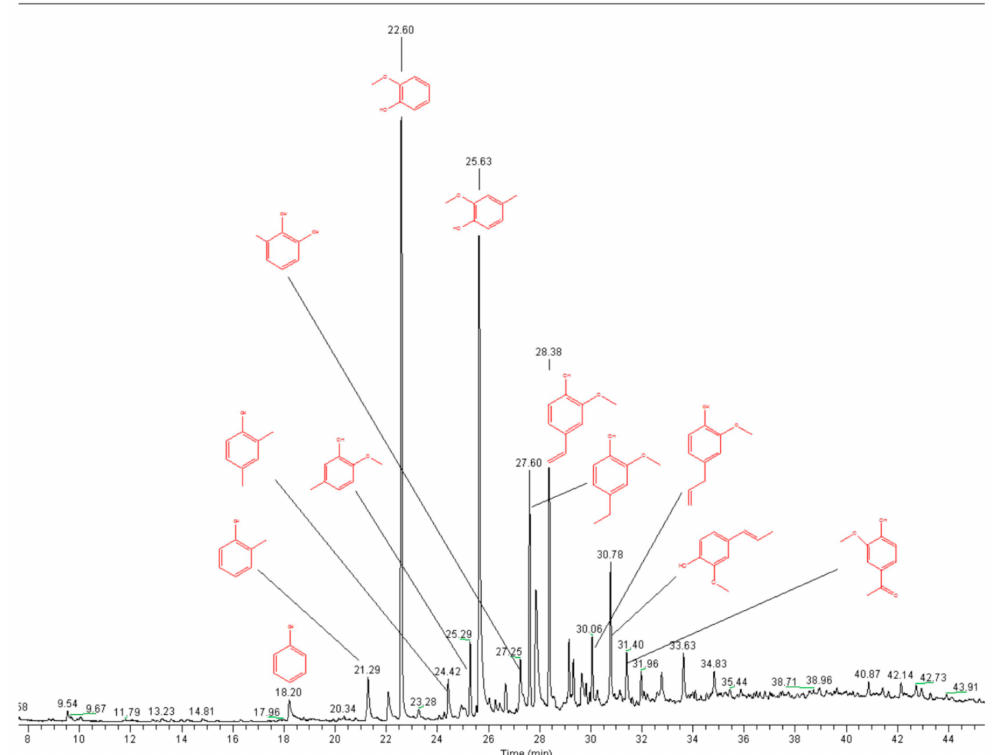
Figure 8. Pyrograms of kraft lignin purification fractions: ( a ) L1, ( b ) L2, ( c ) L3, and ( d ) L4 (measured at 550 ◦ C).